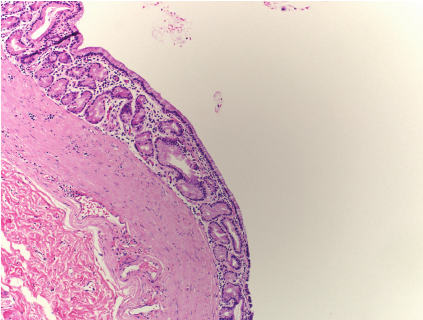
Figure 4: Histological H&E stain. Cystic lesion near the greater curvature of the stomach demonstrating benign developmental cyst lined by mucinous glandular epithelium resembling the epithelium of the stomach and respiratory epithelium. 100x